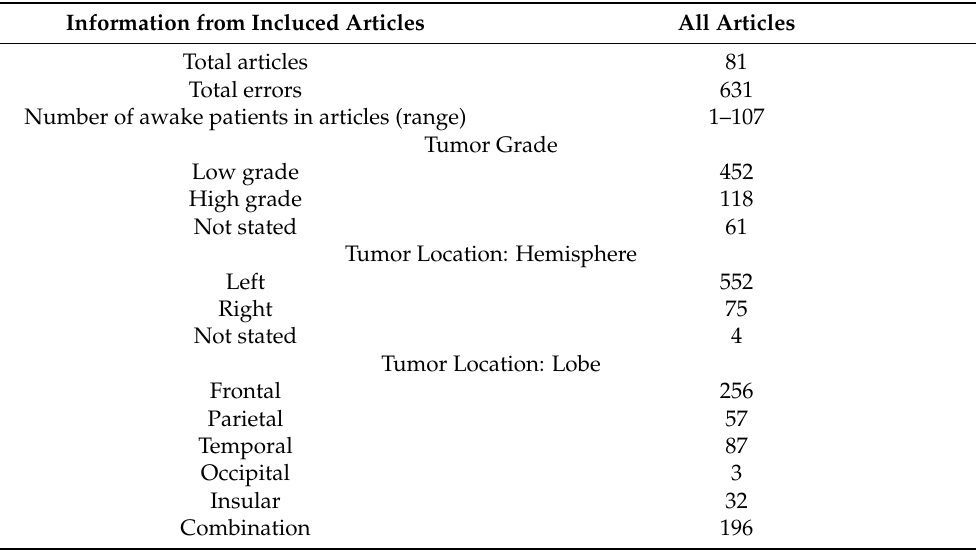
Table 3. Overview of information from included articles.